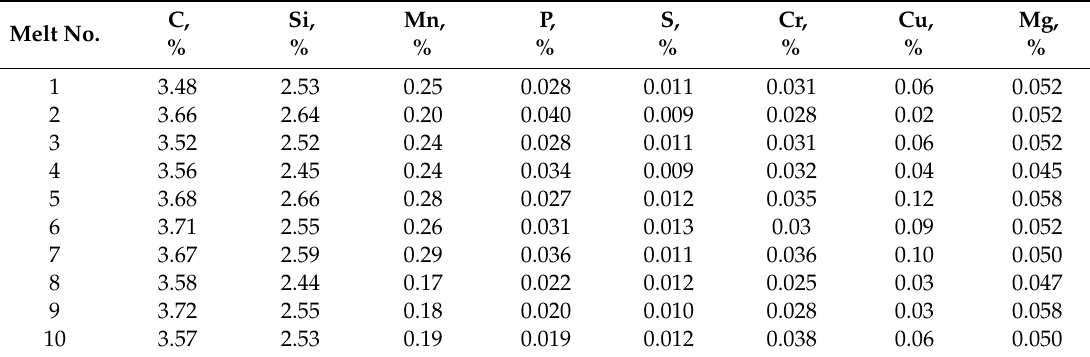
Table 3. Chemical analysis of cast iron after the spheroidization